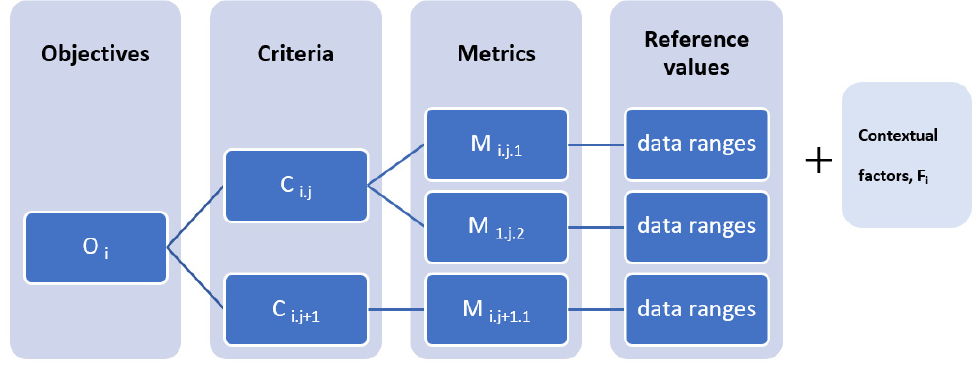
Figure 2. O-C-M-RV tree adapted from [18,19].